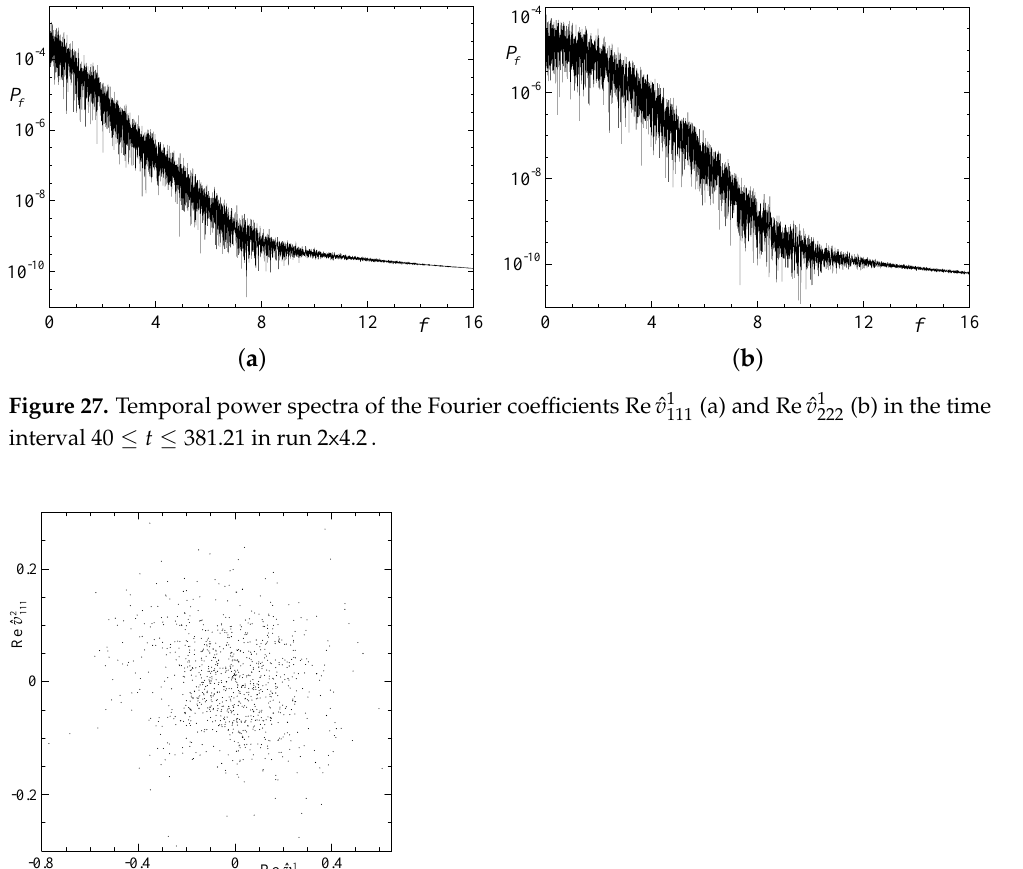
Figure 28. Projection of the Poincaré map of the hyperplane Re ˆ v 3 constructed over the time interval 40 ≤ t ≤ 381.21 for run 2 x